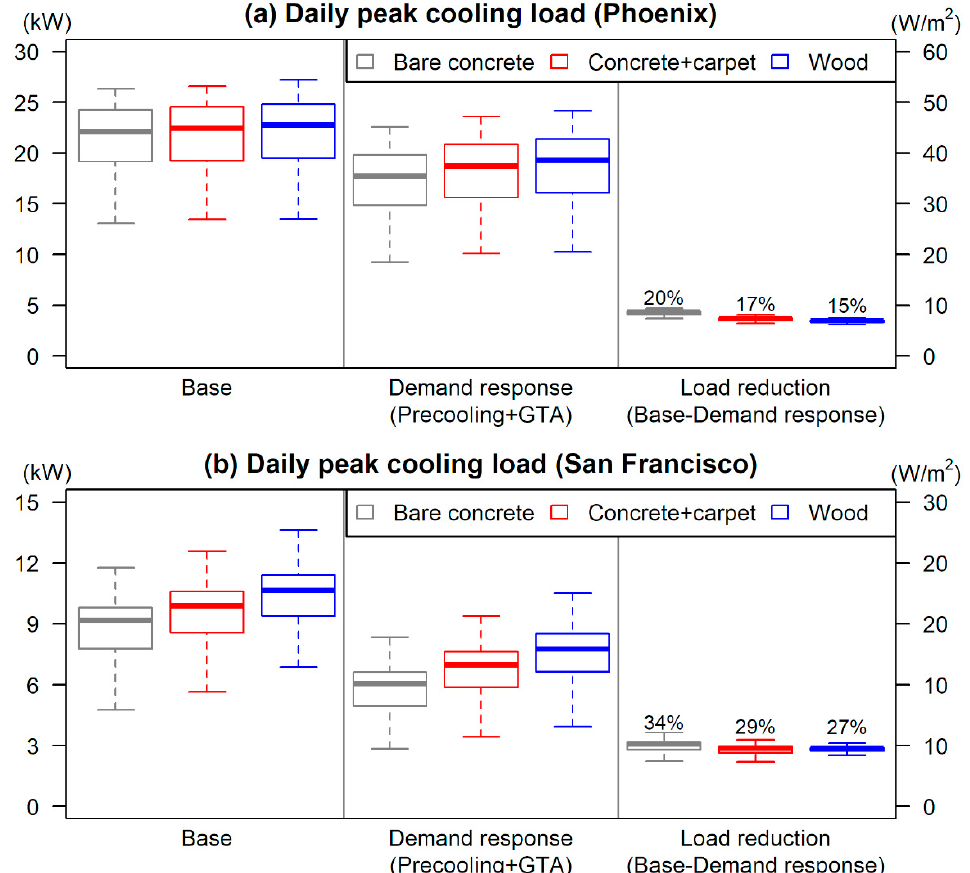
Figure 9. The daily peak cooling loads for the Base and Precooling + GTA scenarios and the reductions compared to the Base scenario for three floor configurations: Bare concrete, Concrete + carpet, and Wood during 106 weekdays from 1 June to 31 October in ( a ) Phoenix, AZ and ( b ) San Francisco, CA. The percentage above a box indicates the median of relative reductions compared to the Base scenario.